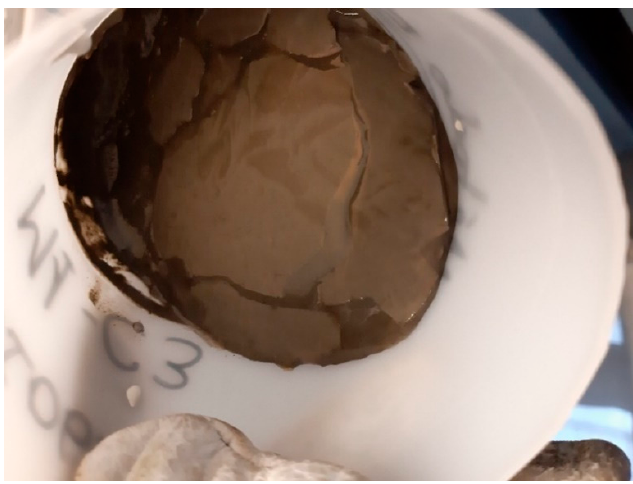
Figure 12. Consistency of Method V, 1 day of thermal bath at 23 °C.